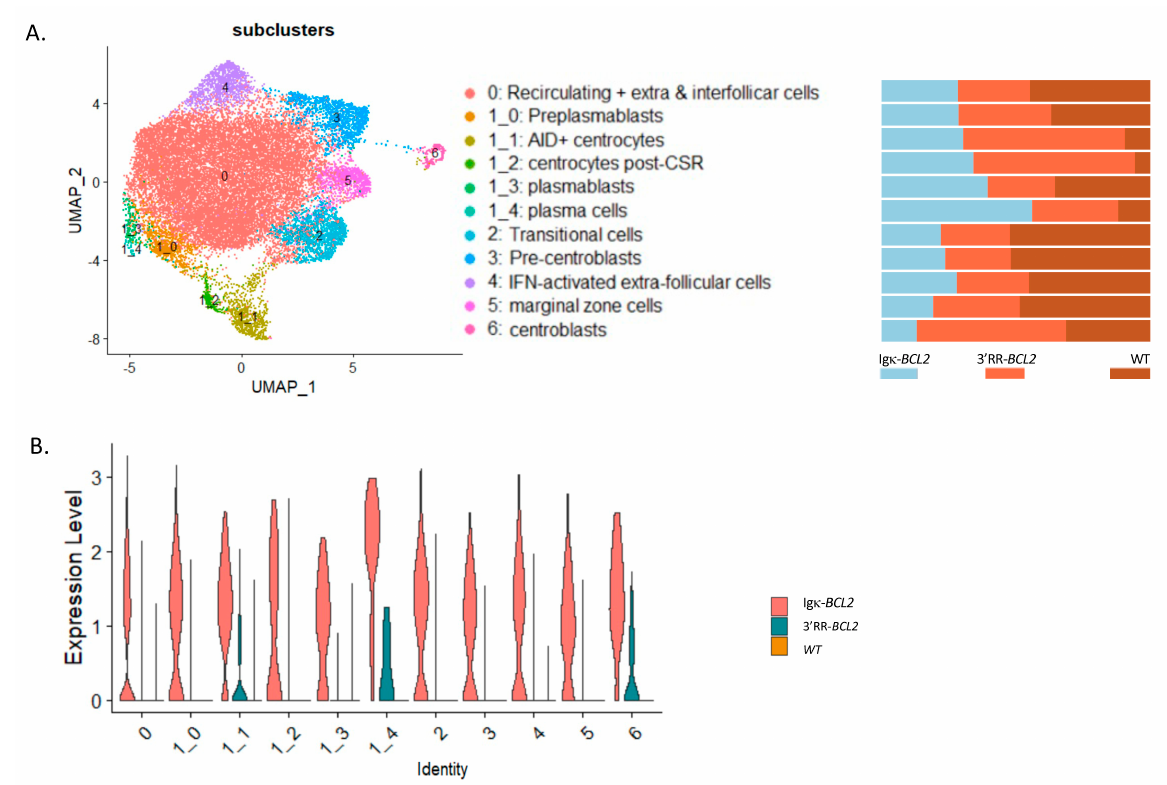
Figure 5. Single-cell RNAseq analysis of splenocytes from immunized mice: ( A , left panel ) UMAP of the 10 × single cell analysis of spleen B-cells 10 days after SRBC immunization, split into 12 clusters (as defined in Supplementary Figure S2). ( A , right panel ) Quantitative variations in cell numbers in the various clusters in Ig κ -BCL2 and 3 ′ RR-BCL2 mice compared to WT. ( B ) Human BCL2 expression level in the various cell clusters in Ig κ -BCL2 and 3 ′ RR-BCL2.